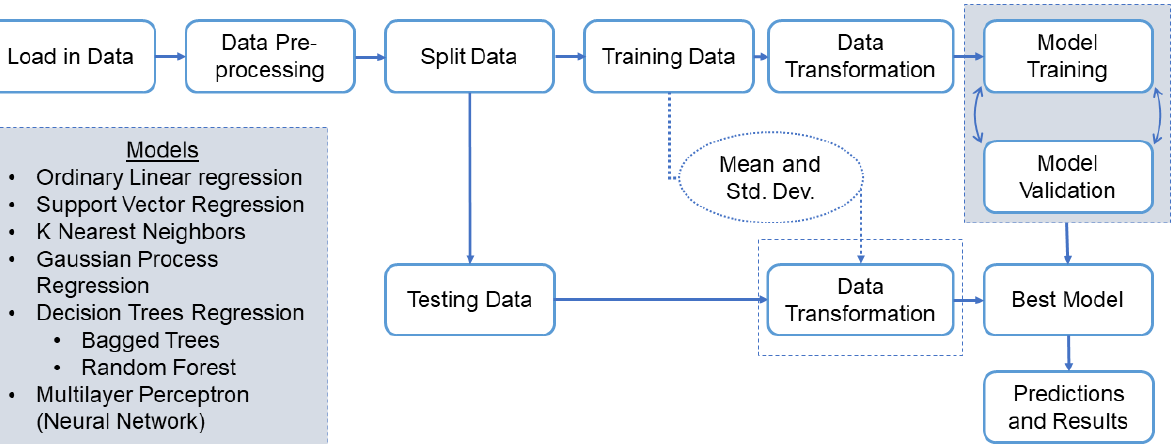
Figure 2. Flowchart of the machine learning pipeline for evaluating different regression models to estimate blood glucose values from a set of noninvasive features.